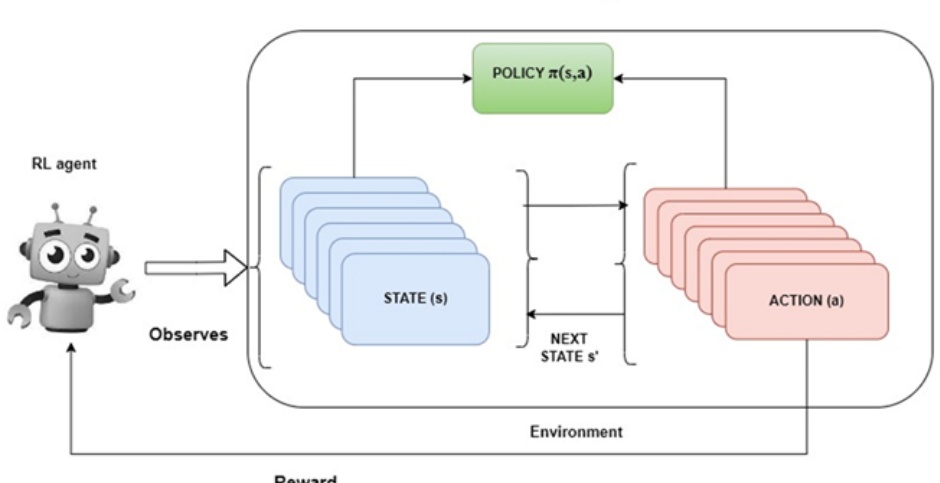
Figure 1. Reinforcement learning framework .